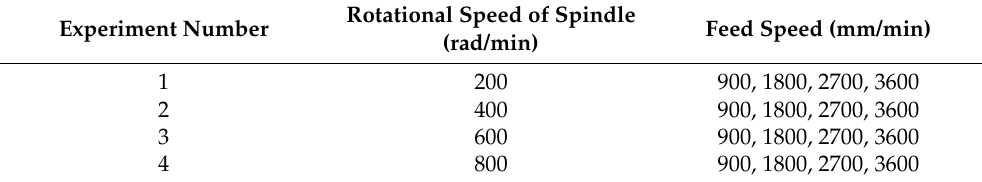
Table 3. Factors of the simulation experiment.